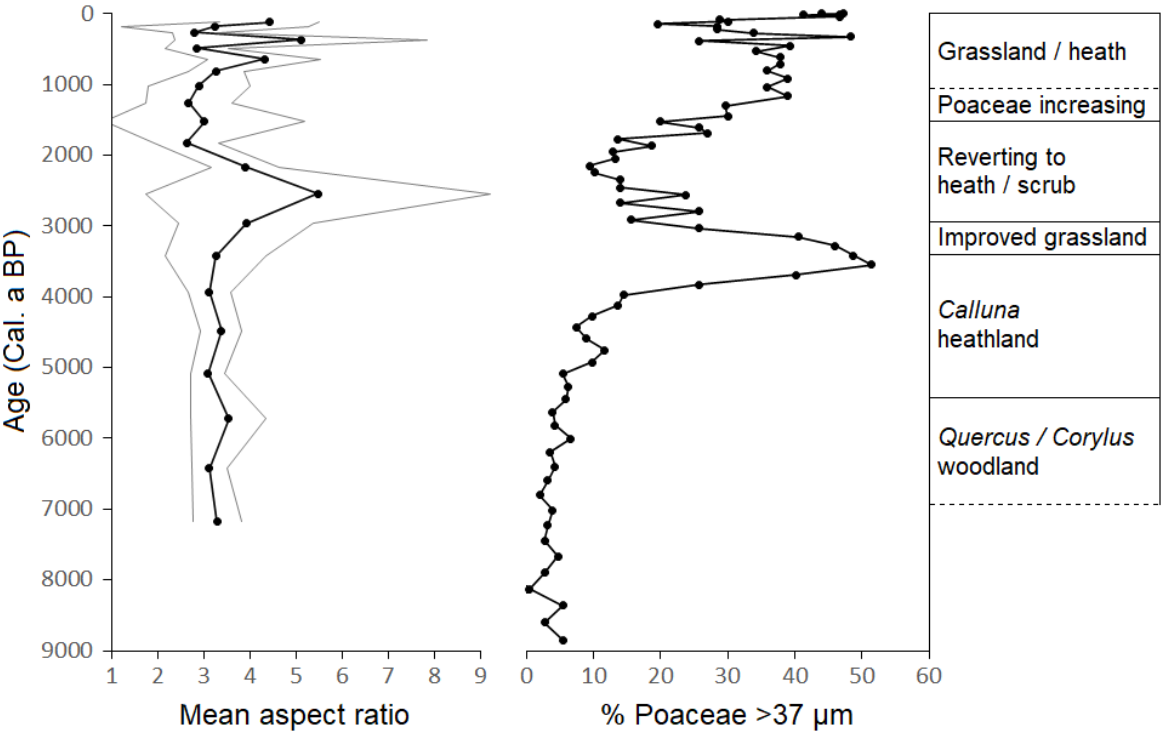
Figure 5. Variation of mean mesocharcoal aspect ratio with age, compared to variation in Poaceae as a percentage of total pollen > 37 µm (Fyfe et al . 2008), and major changes in vegetation as inferred from pollen records by Fyfe et al . (2008). All data are displayed according to the age-depth model described in this study, which differs from that of Fyfe et al . (2008). Grey lines indicate the 95 % confidence intervals for the population means of the aspect